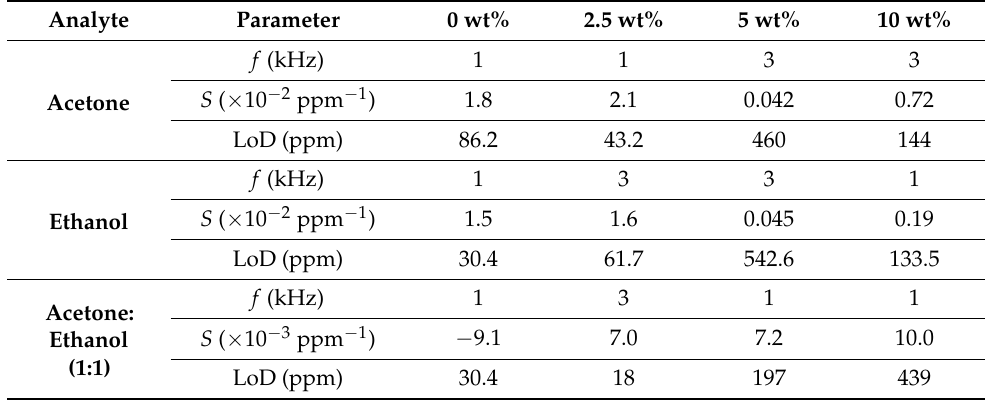
Table 1. Optimum frequency ( f) , determined limit of detection concentration (LoD), and sensitivity ( S) for detection of acetone, ethanol, and acetone: ethanol mixture.